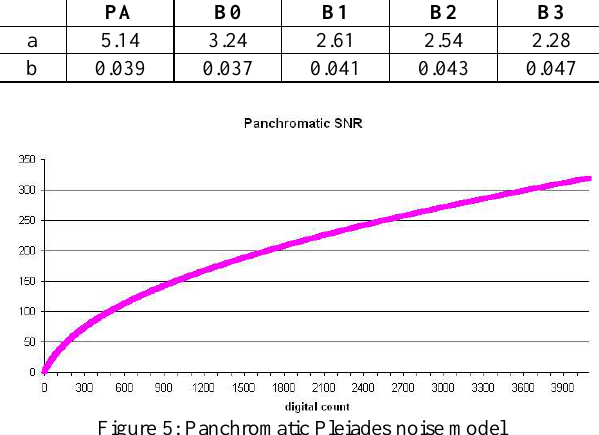
Figure 5: Panchromatic Pleiades noise model